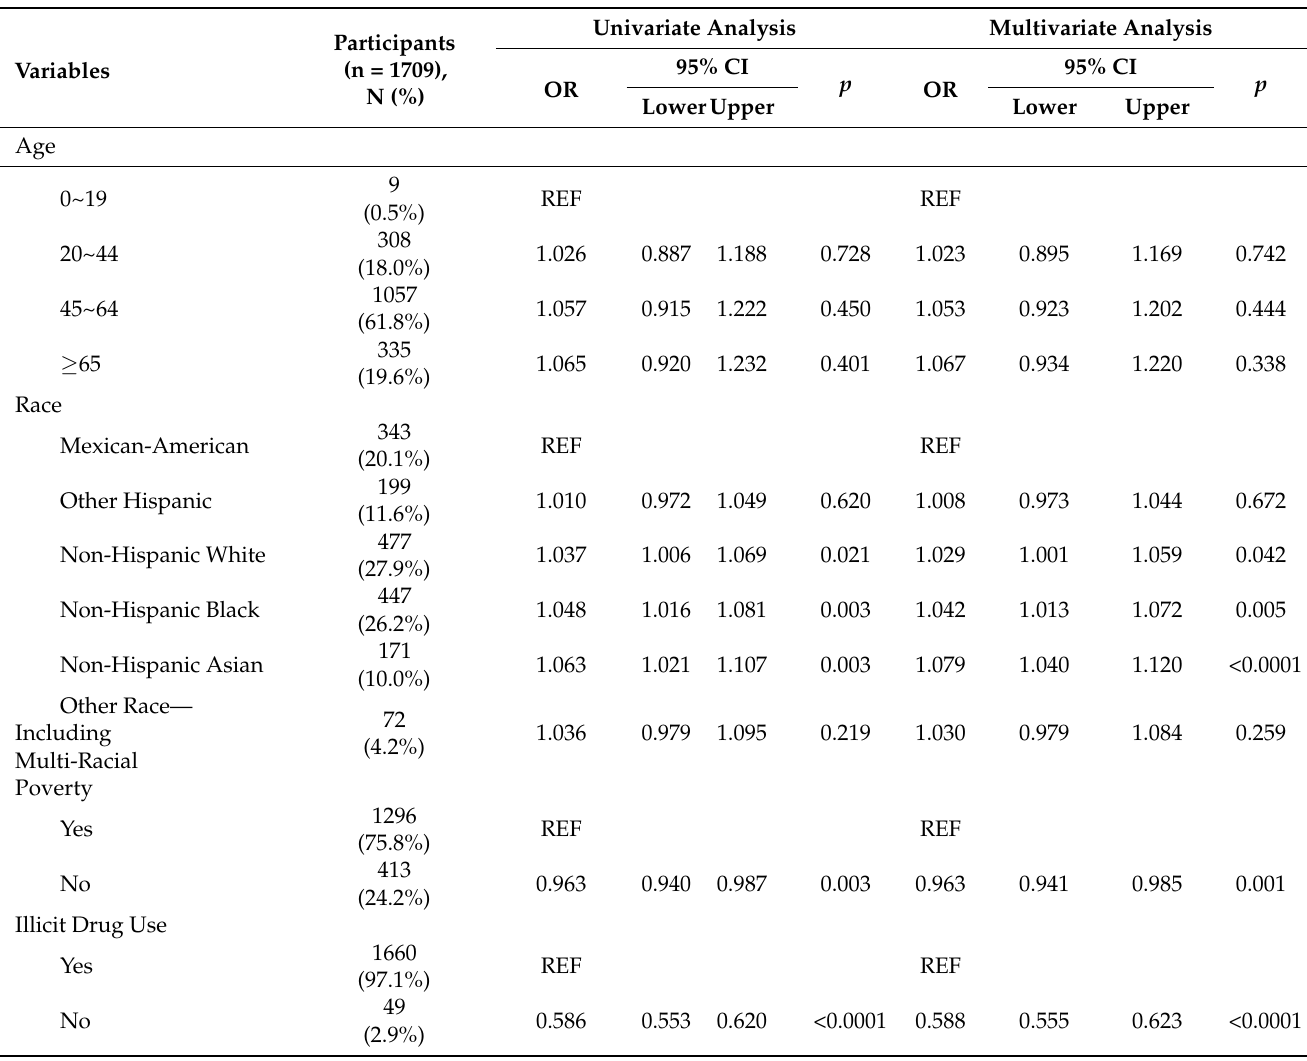
Table 4. Univariate and multivariate odds ratio and 95% confidence intervals for the association of hepatitis B or C with the diabetes mellitus